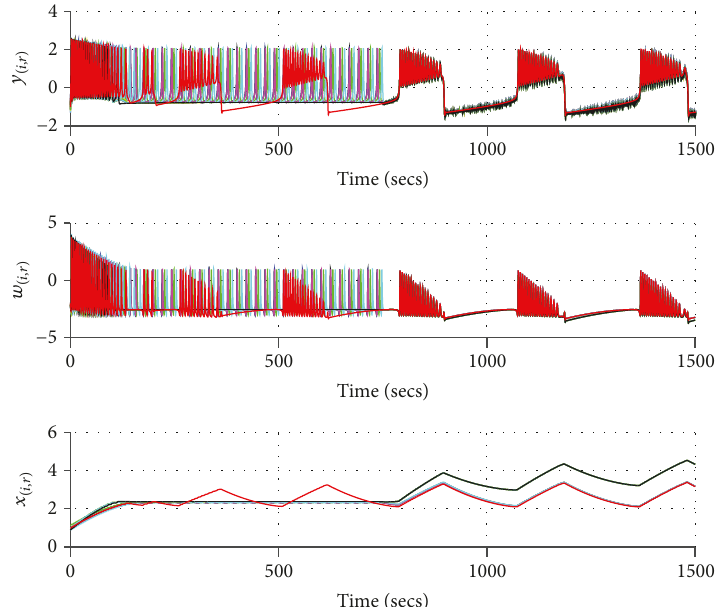
Figure 11: States of the reference β -cell Σ